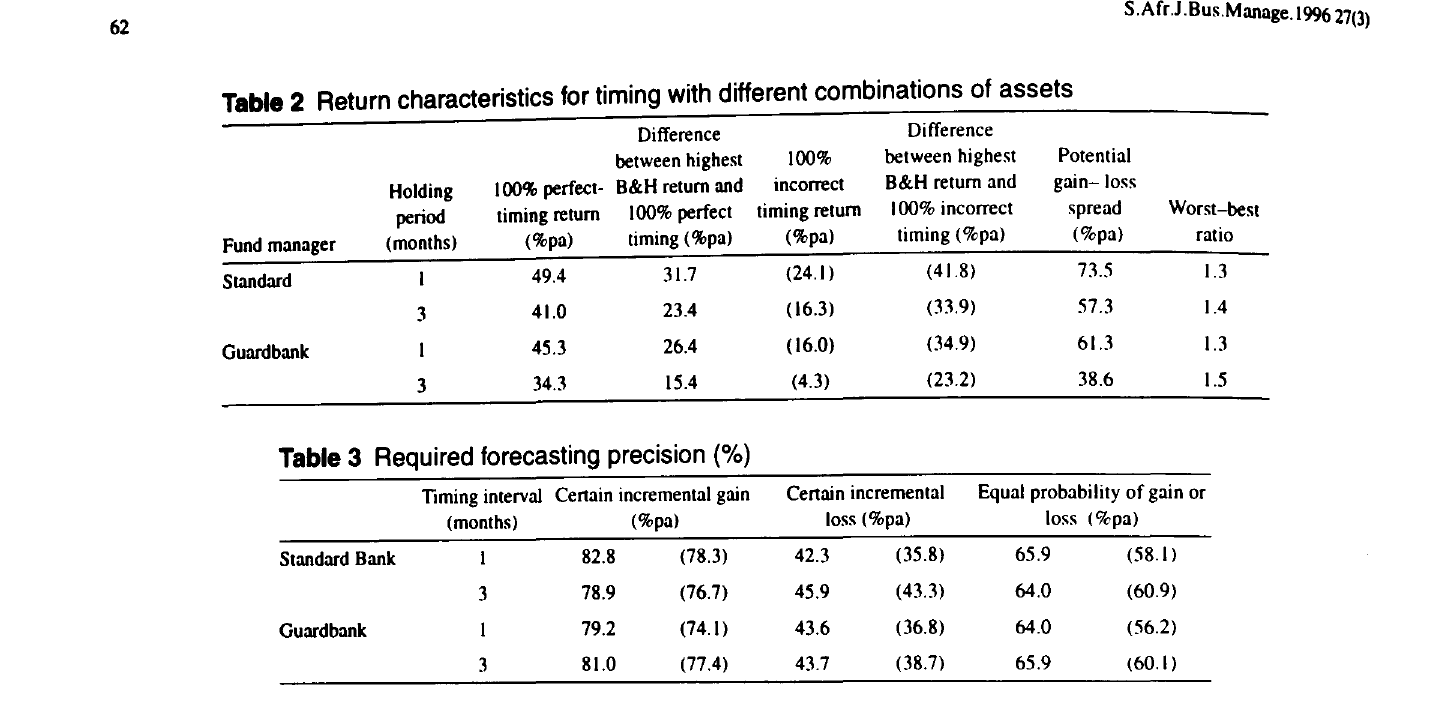
Table 3 Required forecasting precision (%)